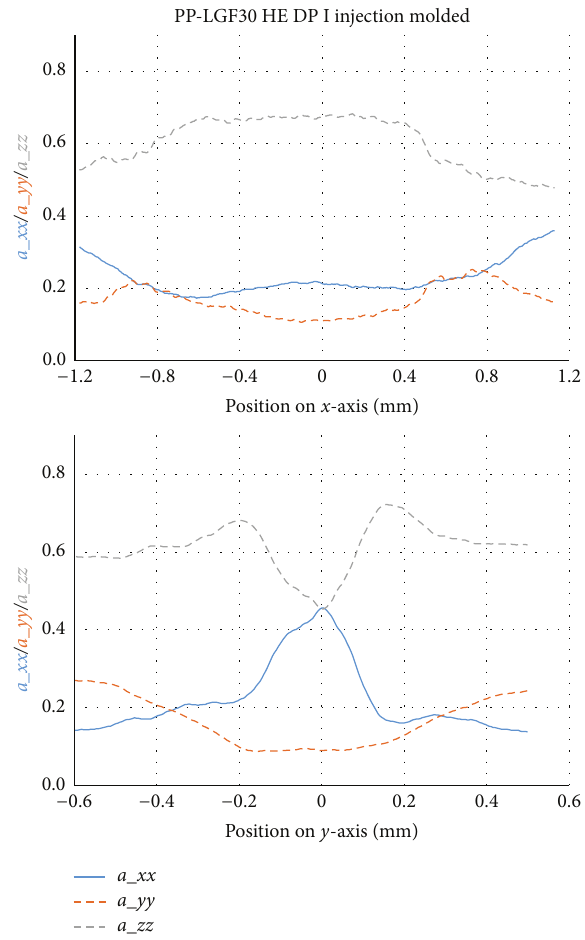
Figure 17: Progress of the fiber orientation along the 𝑥 - and 𝑦 -axis in the weld of injection molded plates in hot plate welding of PP-